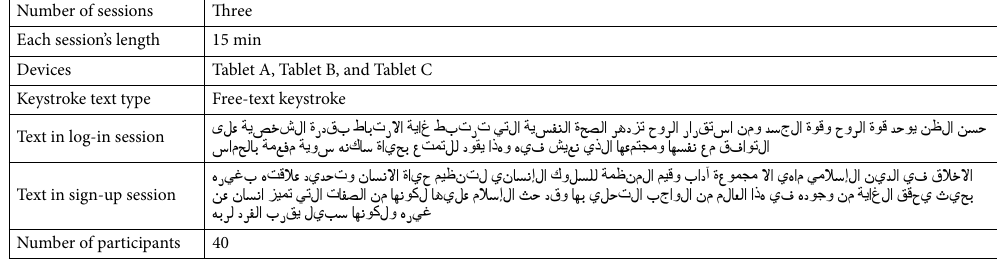
Table 3. Summarizing collected data.